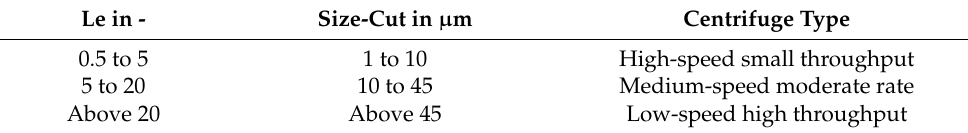
Table 1. Overview of recommended Leung numbers and applications